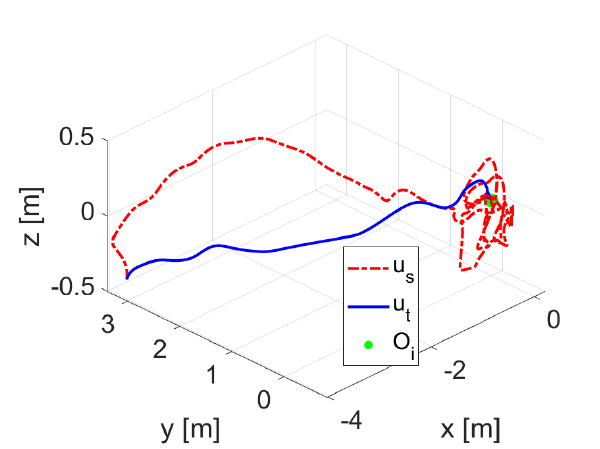
Figure 9. Trajectories obtained by u s and u t for the AUV of F t .